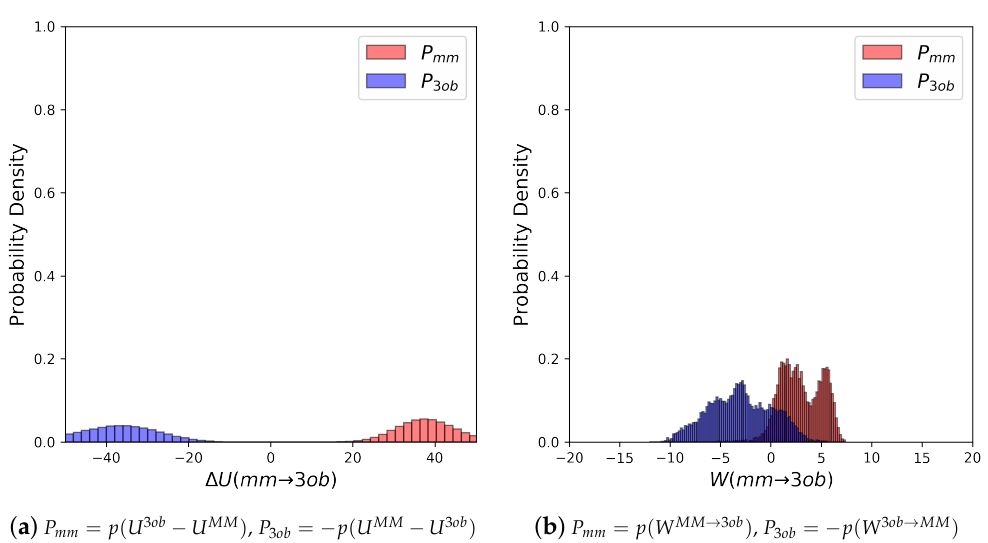
Figure 8. ( a ) Molecule 6 ’s Potential energy “forward” ( P mm ) and “backward” ( P 3 ob ) distributions plotted as “offset” from the ∆ U MM → 3 ob to simplify the x-axis. ( b ) Molecule 6 ’s nonequilibrium work “forward” ( P mm ) and “backward” ( P 3 ob ) distributions plotted as “offset” from the W MM → 3 ob to simplify the